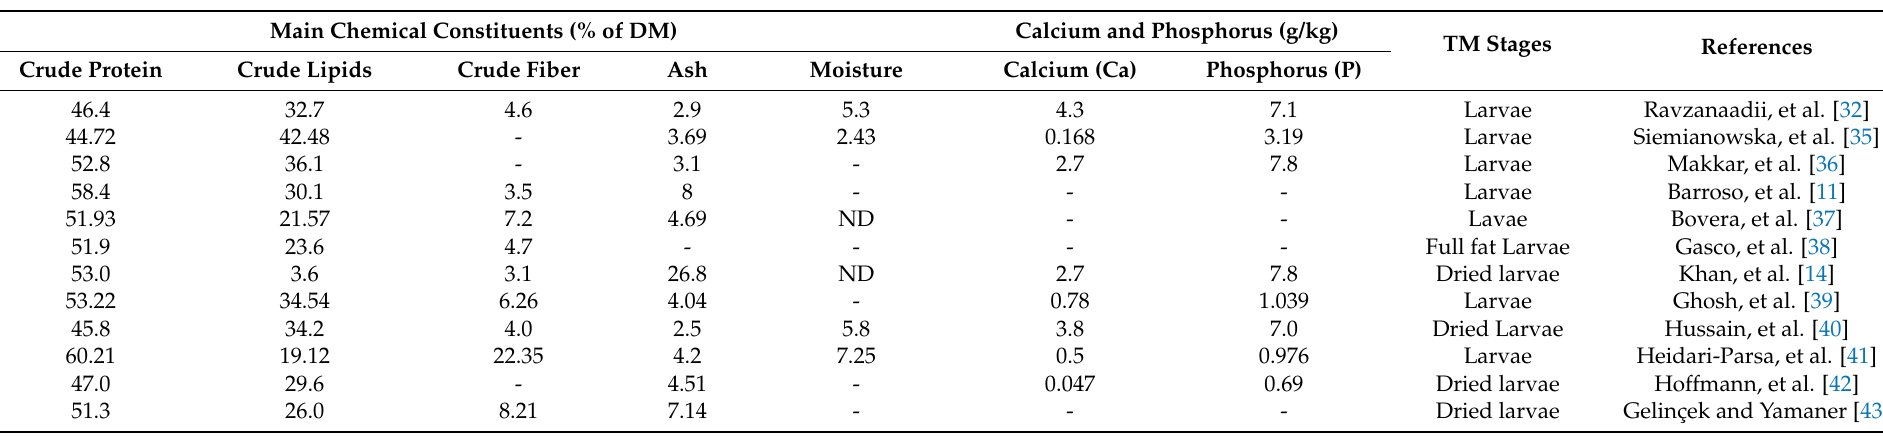
Table 1. Main chemical constituents (% of dry matter (DM)) of the yellow mealworm ( Tenebrio molitor (TM)) according to the previously published literature.